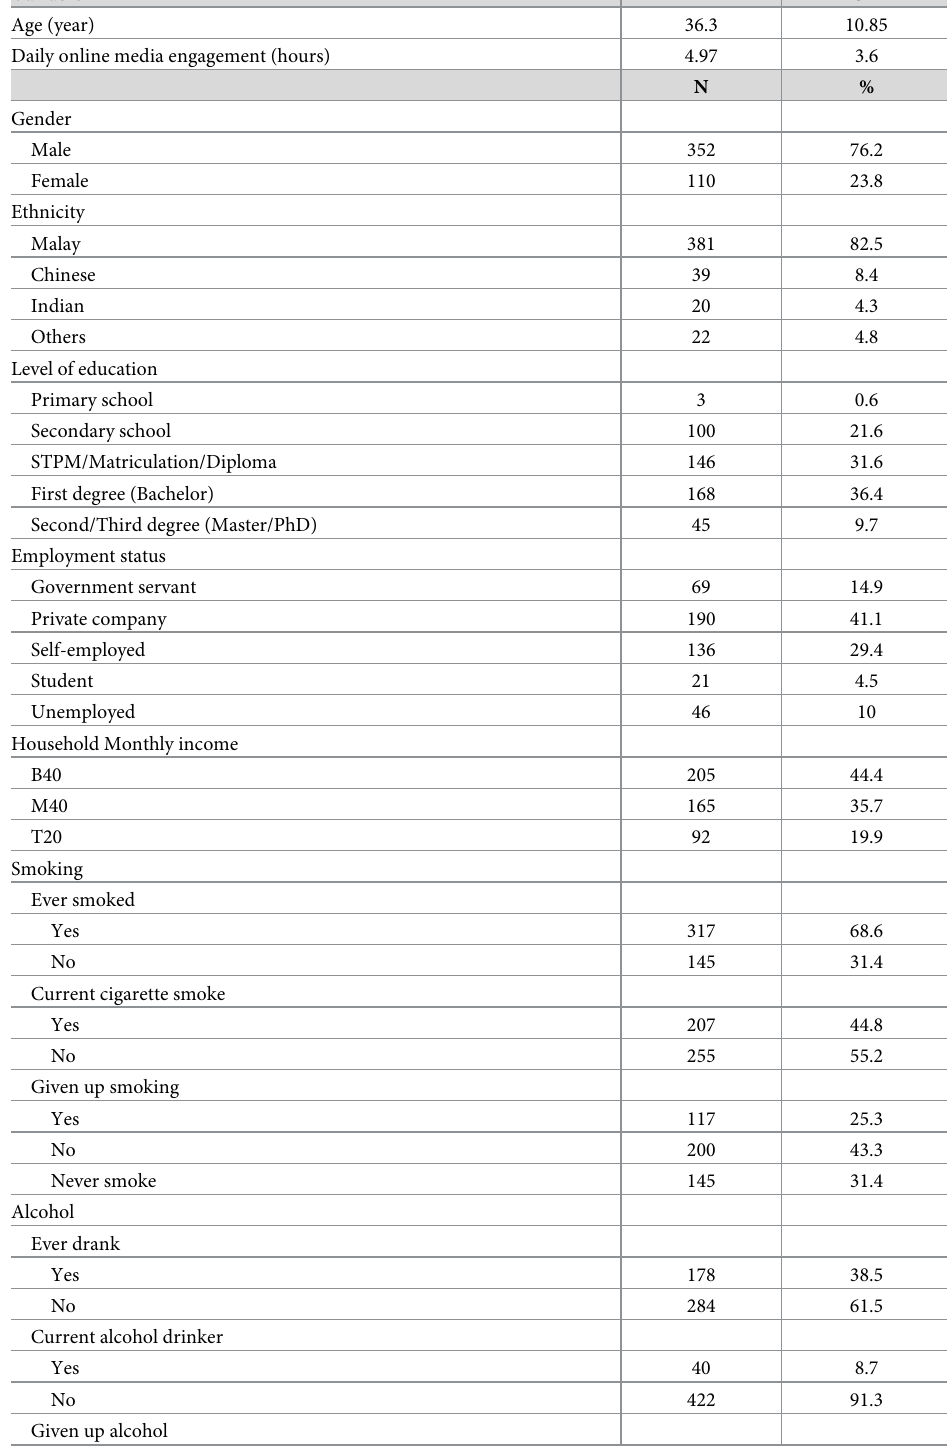
Table 3. Descriptive statistics of the respondents based on sociodemographic, socioeconomic, and lifestyle fac- tors, and perception with acceptance towards decriminalization of medical